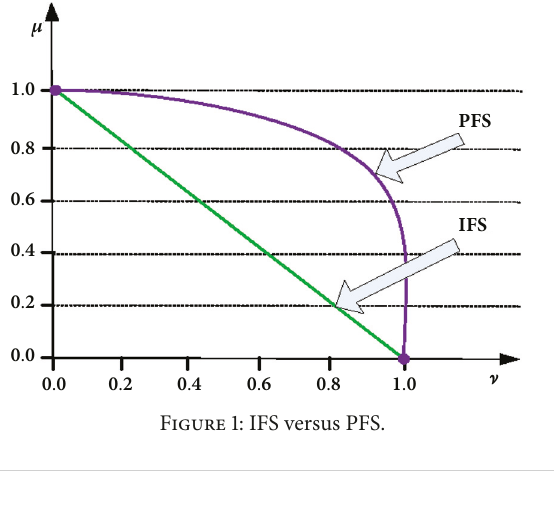
Figure 1: IFS versus